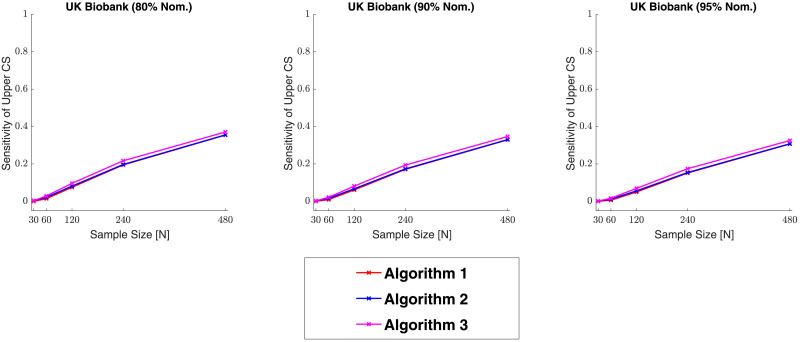
Sensitivity results for the UK Biobank signal, where the UK Biobank full standard deviation image was used as the standard deviation of the subject-level Gaussian noise fields.